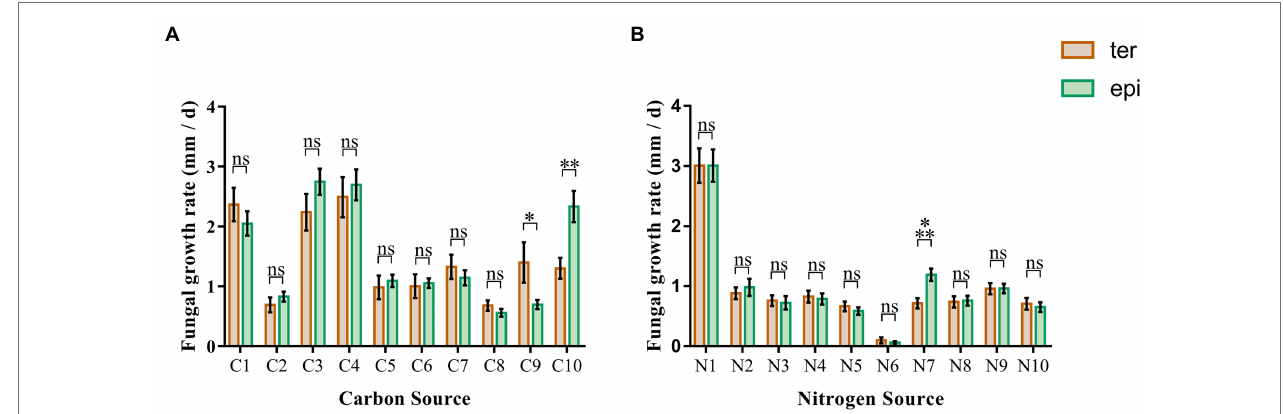
FIGURE 2 | Fungal growth rates in media containing 20 different carbon and nitrogen sources. The green and brown bar represent the average growth rate of epiphytic and terrestrial fungi, respectively. (A) carbon sources; (B) nitrogen sources. C1, glucose; C2, galactose; C3, fructose; C4, xylose; C5, arabinose; C6, mannose; C7, rhamnose; C8, cellobiose; C9, carboxymethyl cellulose; C10, starch; N1, peptone; N2, ammonium sulfate; N3, diammonium phosphate; N4, ammonium Acetate; N5, potassium nitrate; N6, potassium nitrite; N7, arginine; N8, lysine; N9, glycine; N10, urea; and ns, not significant; * p < 0.05; ** p < 0.01; and *** p <